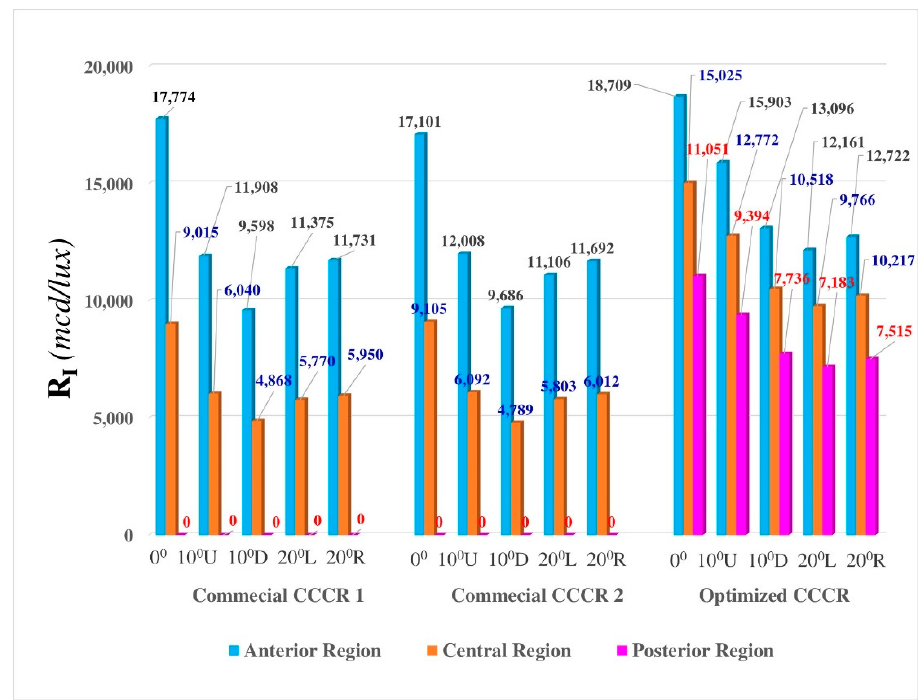
Figure 21. The light distribution for a 0 ° incident light beam on anterior, central and posterior regions of the commercial CCCRs, which are shown in ( a )–( c ) respectively, and those of the optimized SuperPin CCCR are shown in ( d )–( f ).